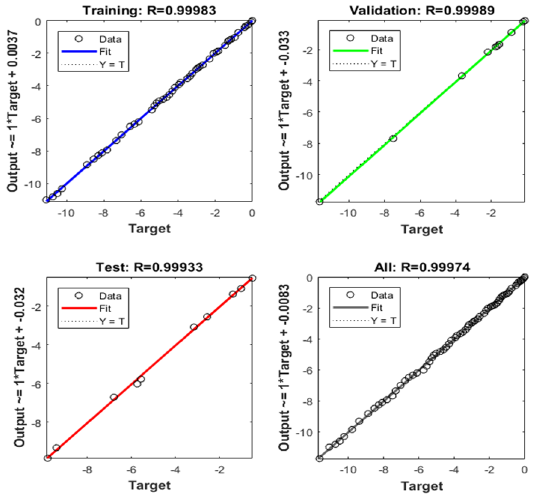
Figure 12. The correlation value of laboratory data and the ANN method (BRC-3 beam).